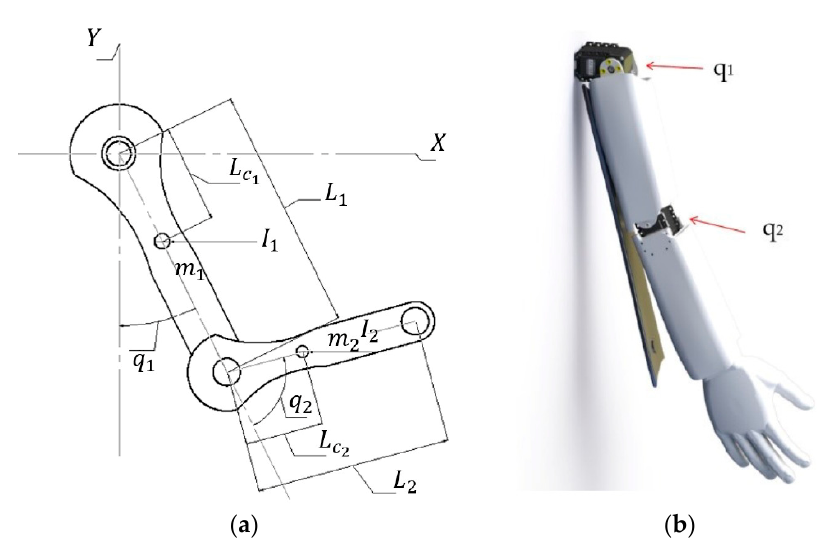
Figure 2. Proposed model: ( a ) mechanism( b ) CAD model.